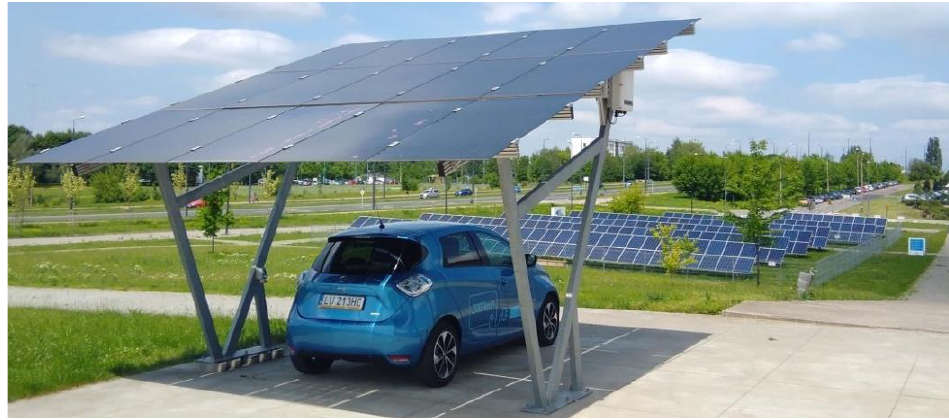
Figure 1. Photovoltaic micro-installation at the LSTP [102].